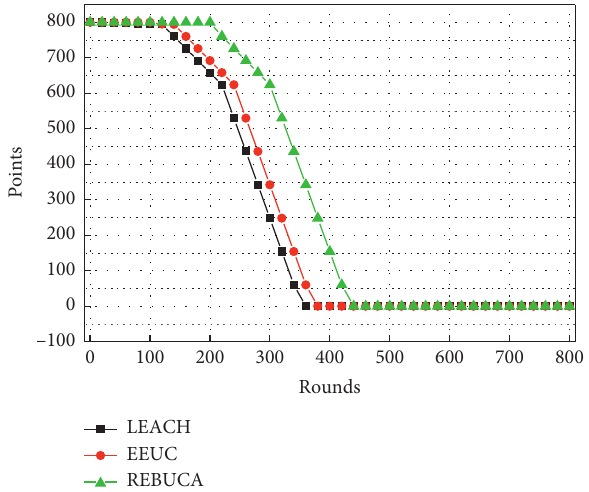
Figure 11: Surviving nodes vs. surviving